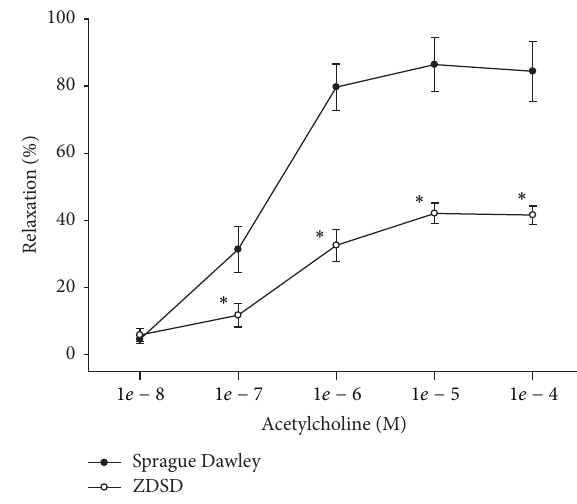
Figure 5: Vascular relaxation by acetylcholine in epineurial arteri- oles from age-matched Sprague Dawley and ZDSD rats. Pressurized arterioles (40mmHg and ranging from 60 to 100 𝜇 m luminal diameter) were constricted with U46619 (30–50%) and incremental doses of acetylcholine were added to the bathing solution while recording steady state vessel diameter. Data are presented as the mean of % relaxation ± S.E.M. The number of rats in each group was 10 and 9 for Sprague Dawley and ZDSD, respectively. ∗ 𝑃 < 0.05 compared to Sprague Dawley rats.